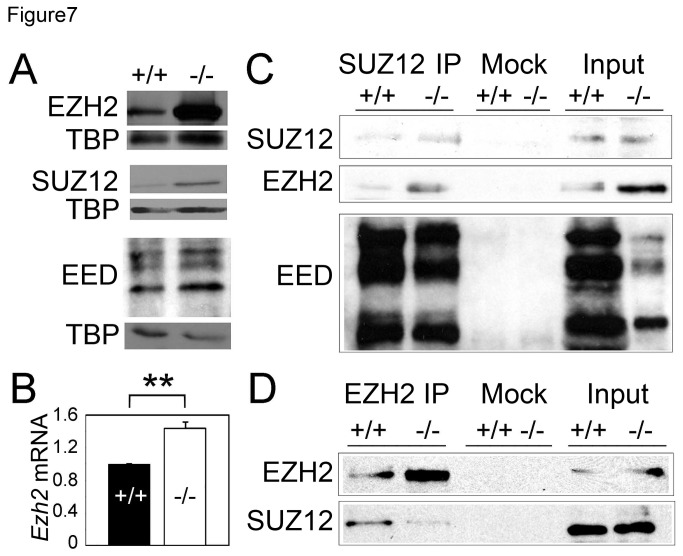
ASXL2 is not required for the protein stability of PRC2 core components or the integrity of PRC2 complex.(A) Western blot analysis of protein levels of EZH2, SUZ12, and EED in wild-type and Asxl2
-/- hearts. Western blot of TATA-binding protein (TBP) was used as a loading control. Three pairs of hearts were analyzed and a representative result was shown for each protein. (B) Real-time RT-PCR analysis of Ezh2 transcripts in wild-type and Asxl2
-/- hearts. **p<0.01; Error bar: standard deviation. (C, D) Co-IP analysis of interaction between PRC2 components. Wild-type and Asxl2
-/- heart extracts were IPed using either an anti-SUZ12 antibody (C) or an anti-EZH2 antibody (D). Mock IP was performed with pre-immune serum. IPed samples were analyzed by Western blot using the indicated antibodies.